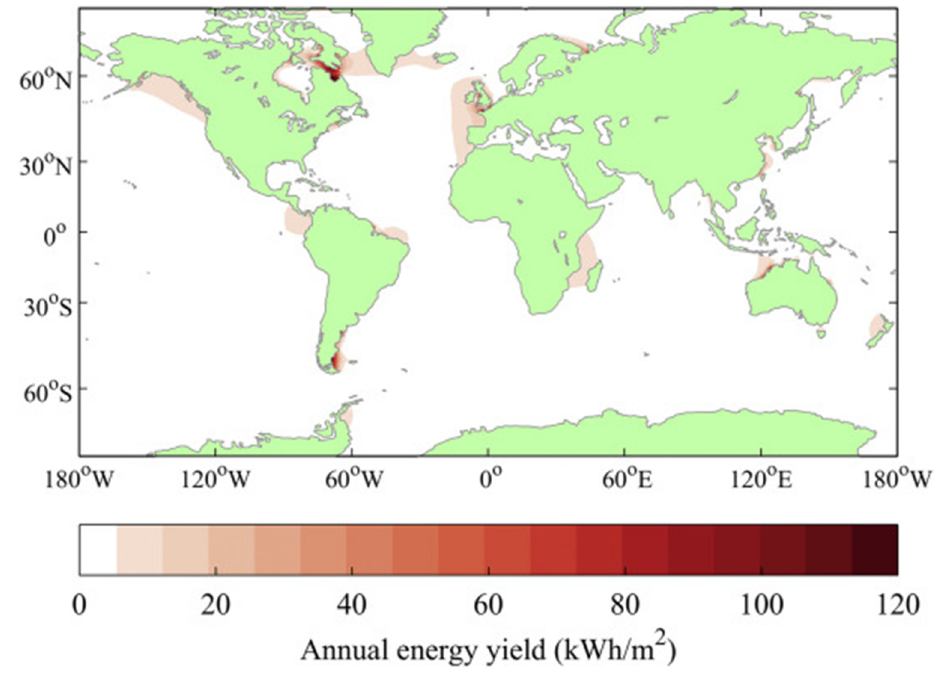
Figure 2. Worldwide distribution potential of the major tidal power computed in kWh/m 2 (adopted from [34] under CC BY-SA 4.0 license). Table 1. Potential locations of tidal energy across the world (summarized from [29–31]).